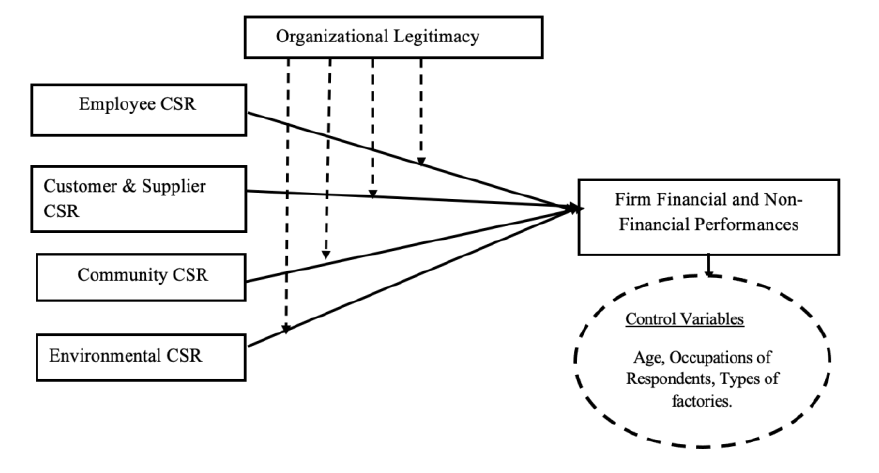
Figure 1: The Conceptual research